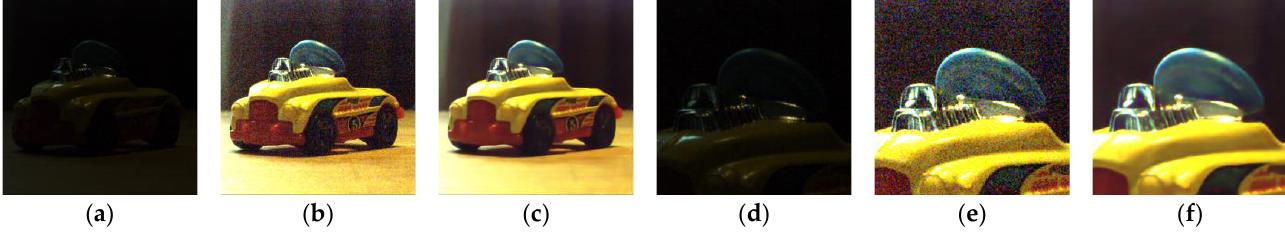
Figure 8. Color image enhancement. ( a ) image acquired at low exposure; ( b ) LIP enhancement of ( a ); ( c ) CNN denoising applied on ( b ); ( d ) zoom on ( a ); ( e ) zoom on ( b ); ( f ) zoom on ( c ).